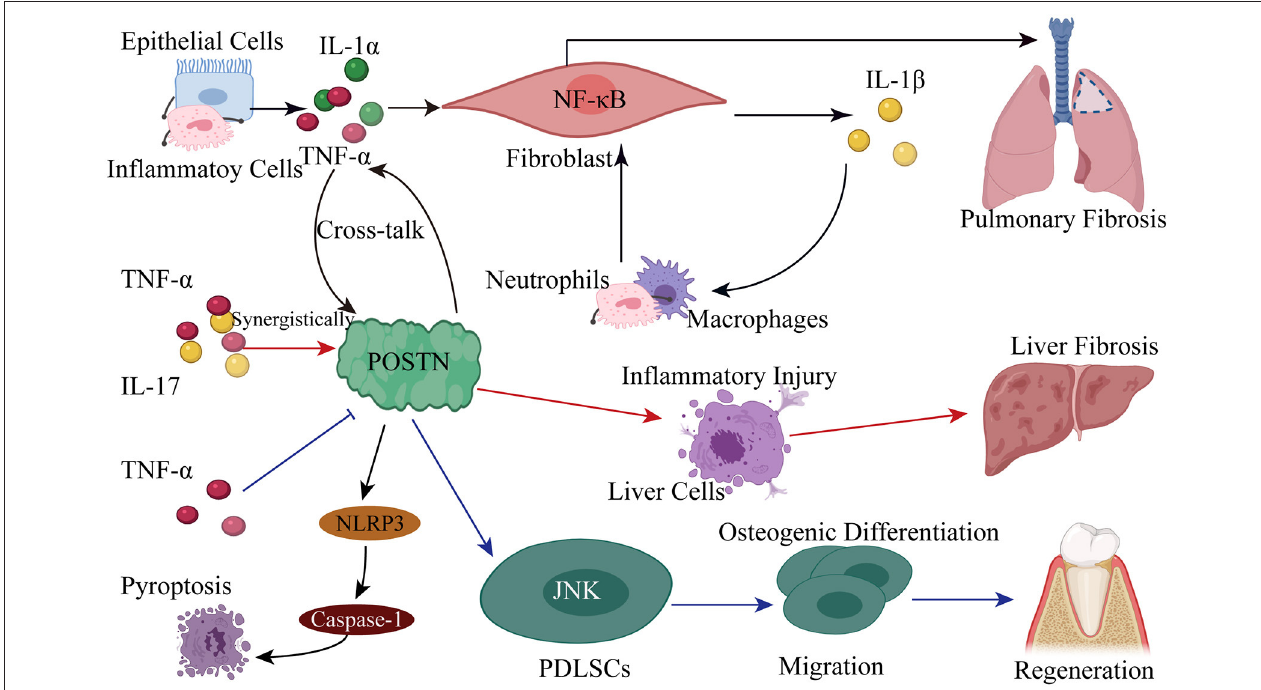
FIGURE 5 | Pro-inflammatory cytokines induce POSTN expression, revealing the underlying mechanism of many chronic inflammatory diseases. (1) POSTN cross-talks with TNF- α or IL-1 α derived from epithelial cells or inflammatory cells to induce various chemokines/inflammatory cytokines, including IL-1 β , by activating the NF- κ B pathway in fibroblasts; this leads to the recruitment of neutrophils and macrophages, which accelerates pulmonary fibrosis. (2) The pro-inflammatory cytokines TNF- α and IL-17 work synergistically to promote the expression of POSTN in order to induce liver inflammatory injury eventually leading to fibrosis. (3) POSTN overexpression promotes caspase 1-mediated pyroptosis by activating NLRP3 in MIRI. (4) POSTN promotes the migration and osteogenic differentiation of PDLSCs by activating the JNK signaling pathway in response to inflammatory